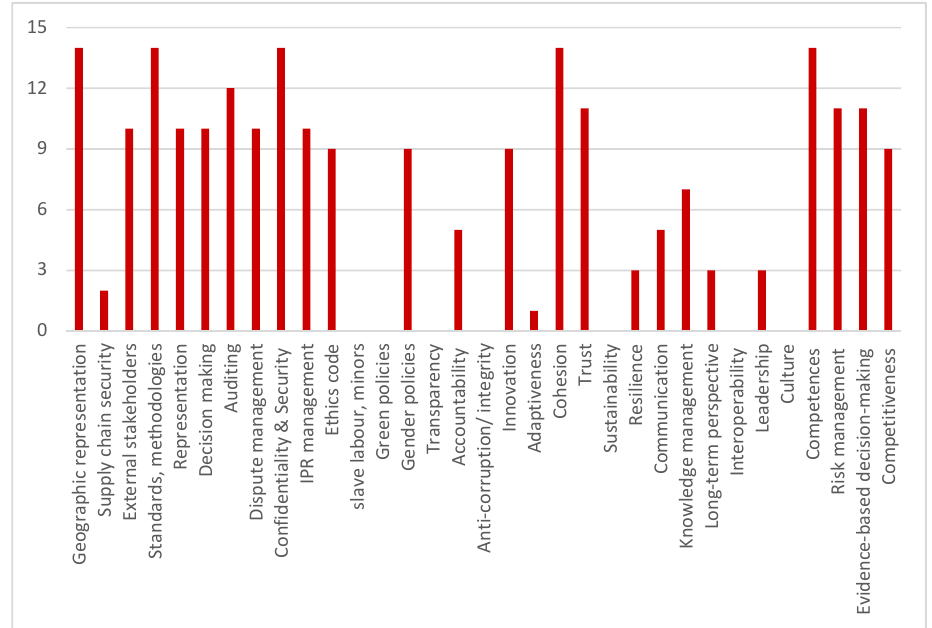
Figure 2. Number of normative documents referencing each governance issue.